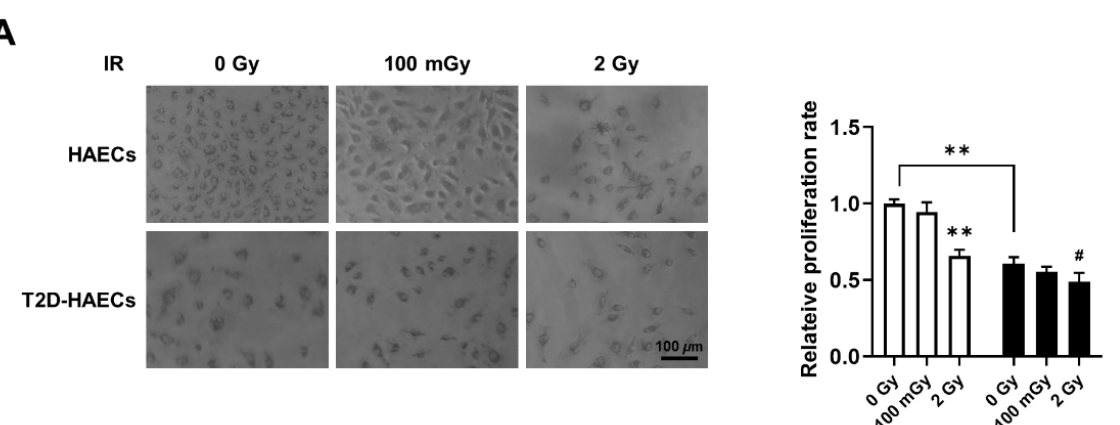
Figure 7. Evaluation of cell proliferation rate, cellular senescence, and tube formation in HAECs and T2D-HAECs after 100 mGy or 2 Gy of ionizing radiation treatments. ( A ) Representative images of cultured HAECs and T2D-HAECs. The proliferative rate of HAECs and T2D-HAECs was measured using an MTT assay (n = 4). ( B ) β -galactose staining and quantification in HAECs and T2D-HAECs. Blue represents β -galactose-positive staining (n = 3). ( C ) Images of tube formation in HAECs and T2D-HAECs 16 h after seeding 1.5 × 10 4 cells/100 μ L. The length and the number of junctions in the tubes were counted and compared in each group (n = 4). All data represent the mean ± SD of three